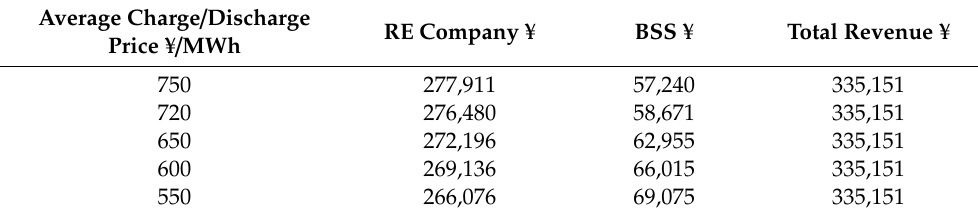
Table 3. The revenue of both sides with di ff erent average charge / discharge price.